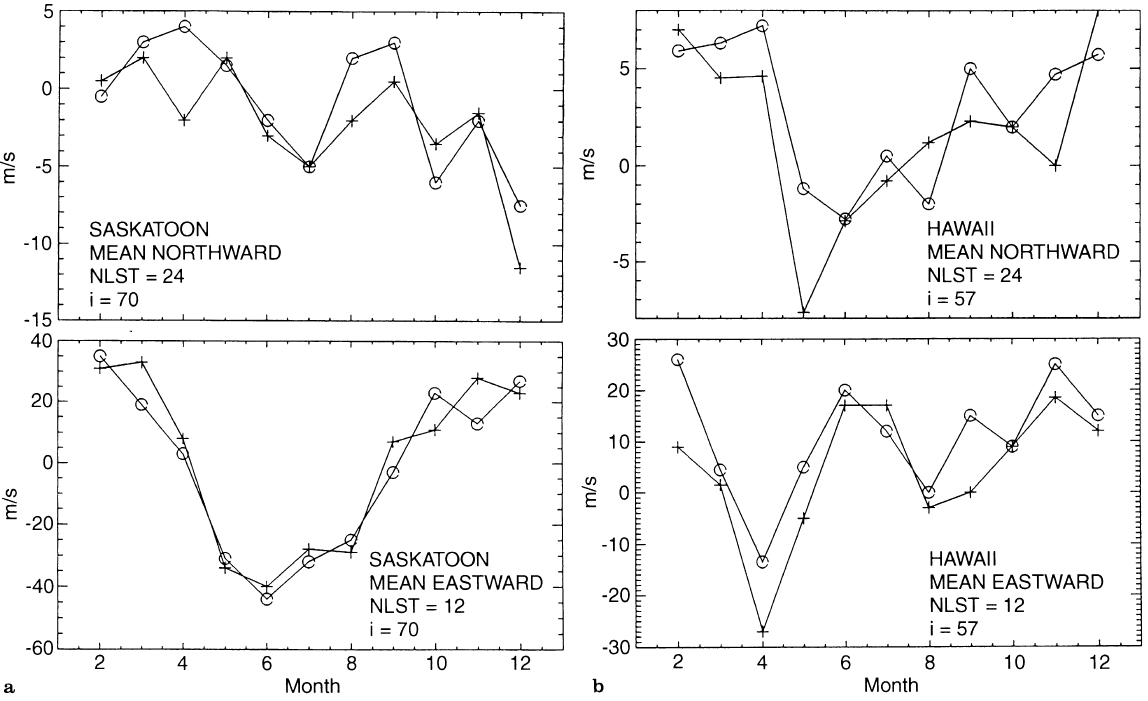
Fig. 1. a Comparison between true ( crosses ) and space-based ( circles ) determinations of mean winds at the latitude of Saskatoon (52 (cid:14) N) for an orbital inclination of 70 (cid:14) . Top : northward wind component for 24-